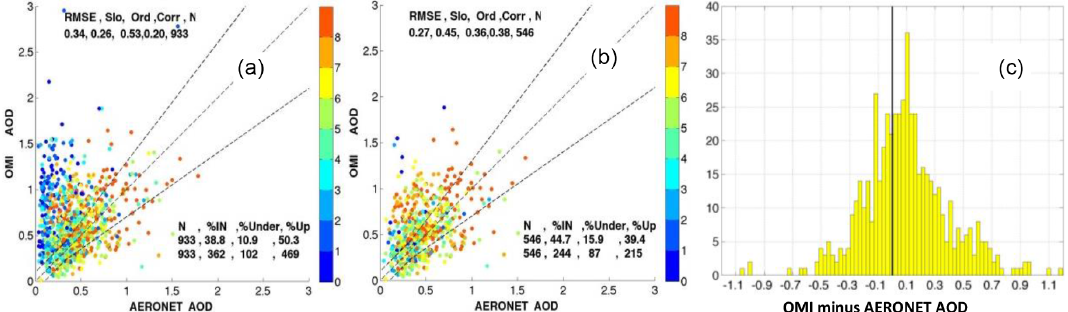
Figure 2. Collocated comparison of OMI AOD 388nm with AERONET AOD 380nm for absorbing aerosols (dust/smoke) as identified by OMAERUV over the ocean. Color bar indicates the number of successful OMI retrievals (out of a possible eight) around the selected OMI pixel used to compare with AERONET. AERONET sites are located along continental coastlines and islands. (a) All AERONET coastal and islands sites. (b) Comparison only for coastal. Root mean square error (RMSE), slope, ordinate, correlation coefficient and number of points used are shown in the upper left. The percentage and actual number of points above, inside and below of the uncertainty envelope are displayed in the bottom right of each figure. The black dashed lines are the 1-to-1 line and the uncertainty envelope (defined as 0.1 for AOD<0.3 and 30% for AOD>0.3, Torres et al., 2007). (c) The histogram of OMI minus AERONET AODs for (b)